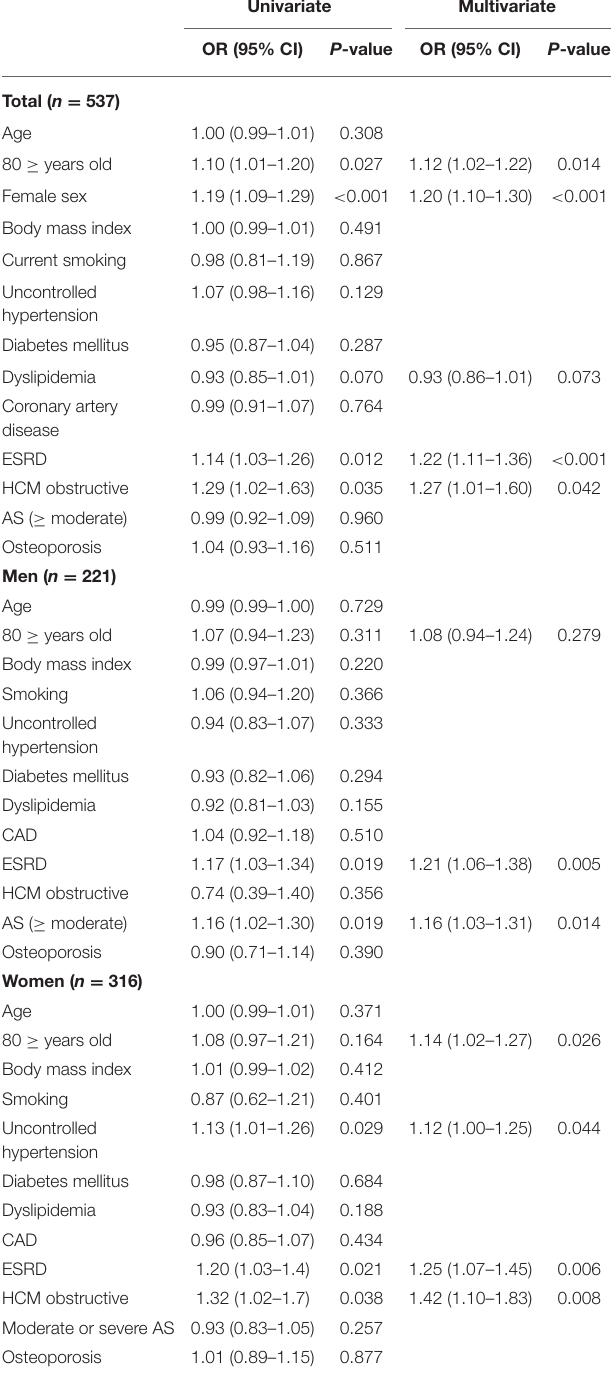
TABLE 3 | Associating factors with moderate to severe MAC. Univariate